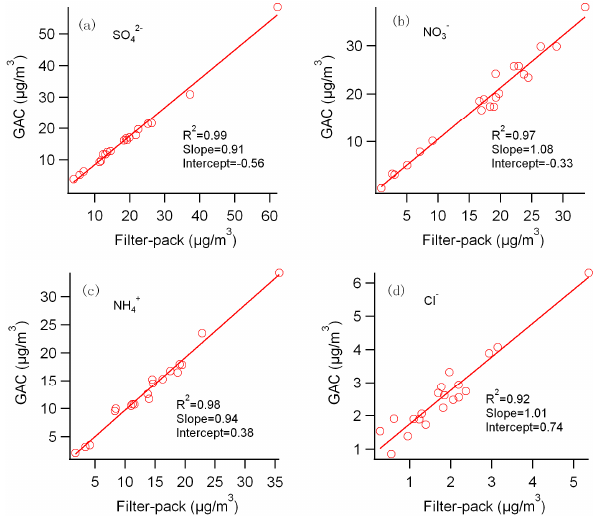
Fig. 7. Inter-comparison between the GAC-IC system and the filter Fig.7. Inter-comparison between the GAC-IC system and the filter measurement measurement equipped with denuder and backup equipped with denuder and backup filters.